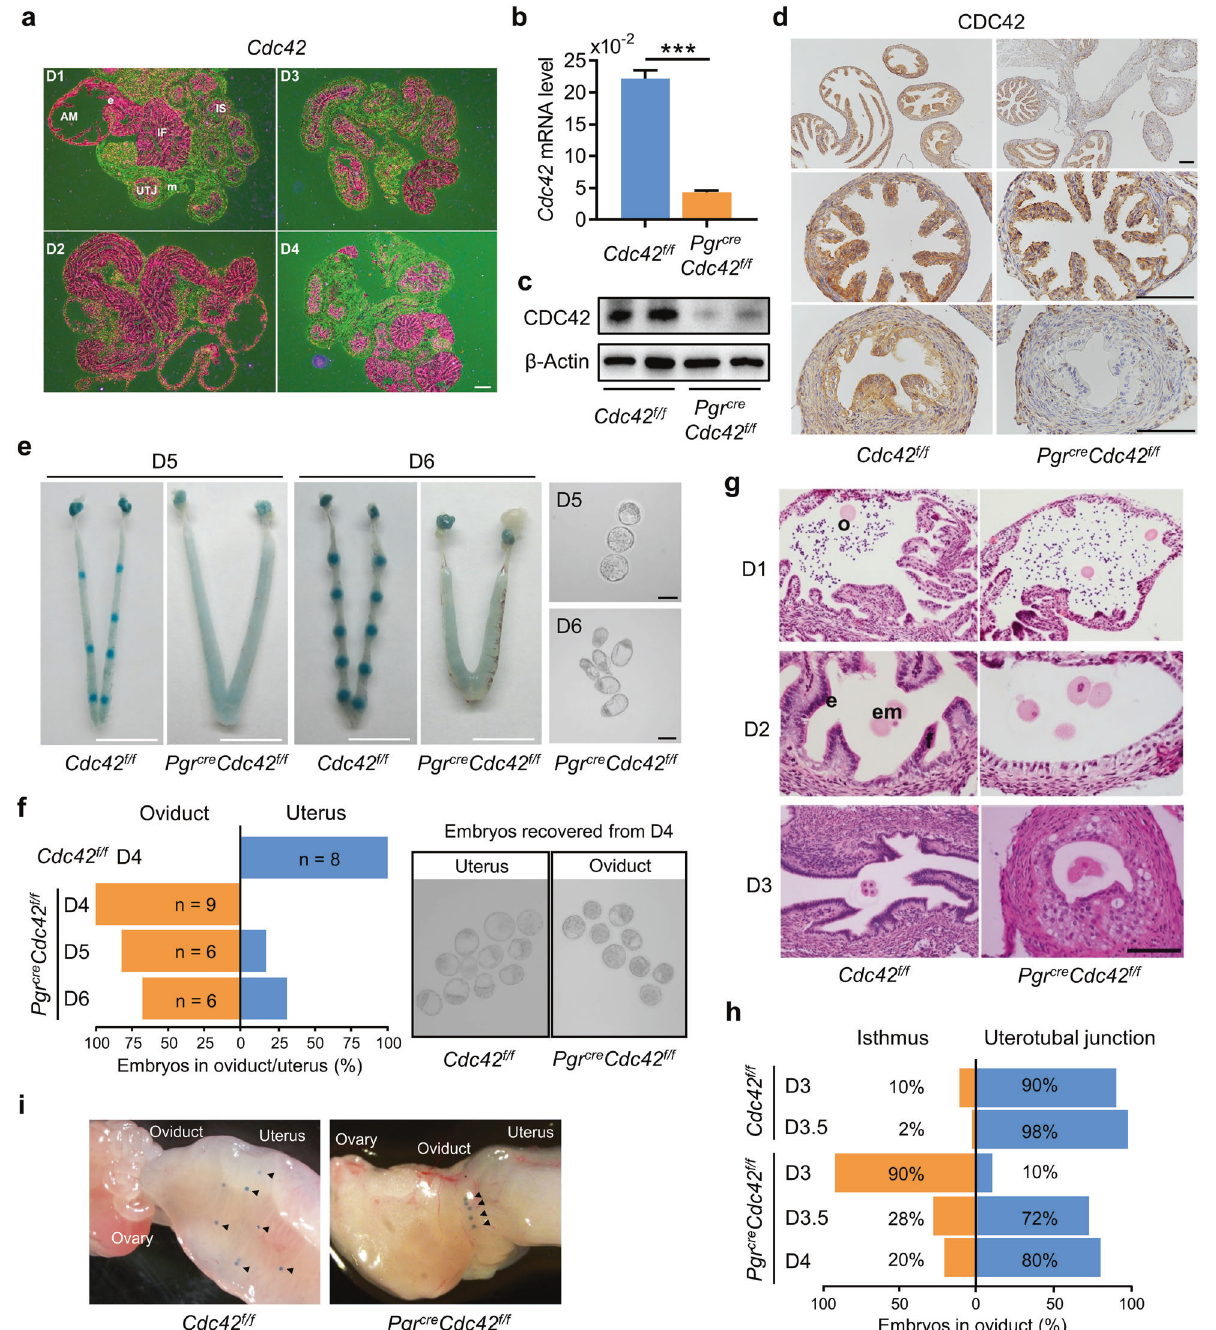
Fig. 1 Loss of CDC42 in the oviduct leads to defective embryo transport. a In situ hybridization of Cdc42 mRNA in D1-4 oviducts. b RT-qPCR analysis of Cdc42 mRNA and c Western blot analysis of CDC42 protein in Cdc42 f/f and Pgr cre Cdc42 f/f mouse oviducts. d Immunostaining showed that CDC42 was lost in the isthmus, but not in the ampulla of Pgr cre Cdc42 f/f mouse oviducts. e Pgr cre Cdc42 f/f mice exhibit implantation failure recovered with small numbers of morphologically normal blastocysts upon fl ushing the uterine horn on day 5 and 6 of pregnancy. f Percentage of embryos recovered from oviducts or uteri. Recovered blastocysts from Cdc42 f/f mouse uteri and Pgr cre Cdc42 f/f mouse oviducts on day 4. g Oocytes in the ampulla on day 1 and embryos in the isthmus on day 2 of both Cdc42 f/f and Pgr cre Cdc42 f/f mice. Embryos enter in the uterobutal junction of Cdc42 f/f mice, while retained in the isthmus of Pgr cre Cdc42 f/f mice on day 3. h Percentage of embryos recovered from the isthmus and uterotubal junction. i Af fi -Gel Blue Gel beads transferred into the oviduct umbrella of D1 pseudopregnant mice enter in the uterus of Cdc42 f/f mice, while retained in the isthmus of Pgr cre Cdc42 f/f mice on day 4. Arrowheads, sites of transferred gel beads. IF infundibulum, AM ampulla, IS isthmus, e epithelium, em embryo, o oocyte. Black scale bars, 100 μ m. While scale bars, 1 cm.